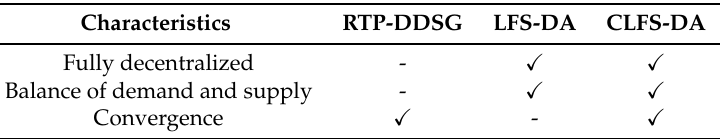
Table 1. Characteristics of the related mechanisms. RTP-DDSG: real-time pricing dual decomposition with a sub-gradient method; LFS-DA: linear function submission based double-auction; CLFS-DA: convergent linear function submission-based